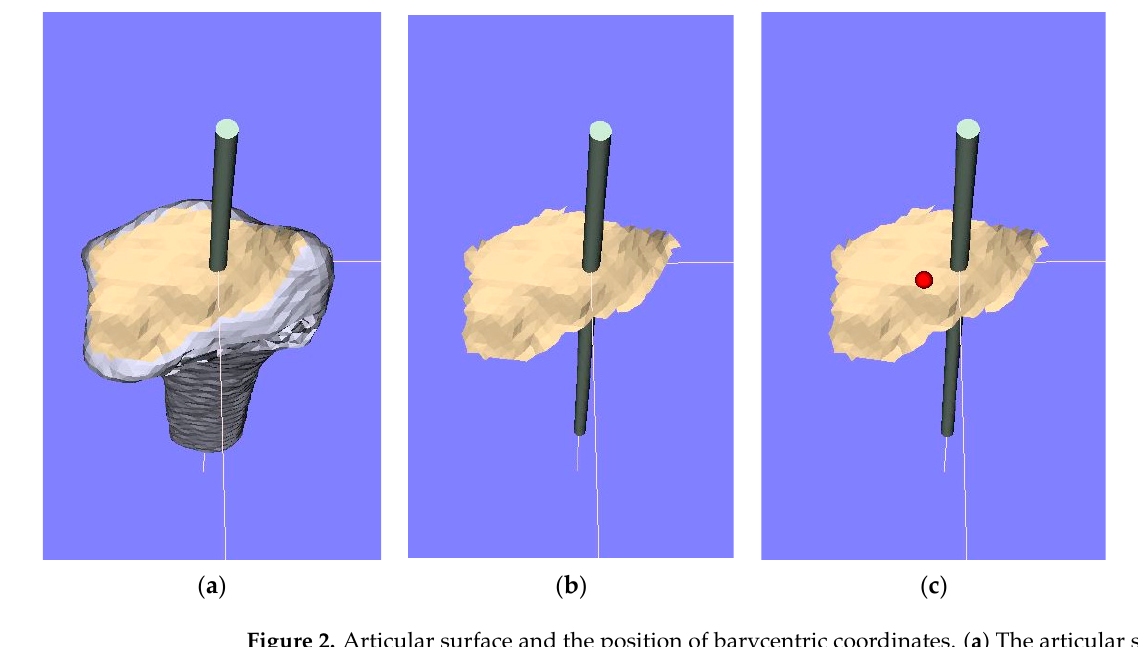
Figure 2. Articular surface and the position of barycentric coordinates. ( a ) The articular surface of the 3D model was identified with the bony prominence of the distal radius, ( b ) the articular surface was extracted, and ( c ) the surface area and position of the barycentric coordinates (red dots) were calculated. The bar indicates the long axis of the radius. The 3D measurement indices corresponding to the X-ray measurement were meas- ured. The angle between the line connecting reference point (2) to reference point (3) and the line perpendicular to the longitudinal axis of the radius were measured as the palmar tilt (PT) on a 3D image in the sagittal view. The angle between the line from reference point (1) to reference point (2) and the line perpendicular to the longitudinal axis of the radius were measured as the radial inclination (RI) on a 3D image in the coronal view (Figure 3).